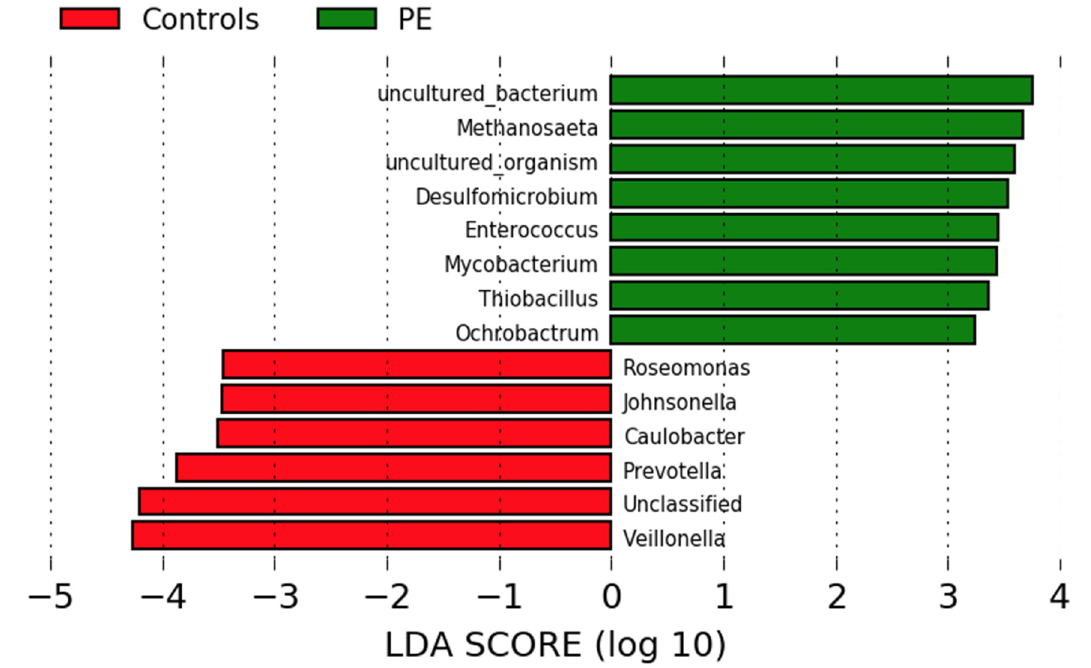
Figure 2. Comparison of the gut microbiota composition in women who developed preeclampsia and normotensive women. LEfSe analysis at the genus level of the oral microbiota of women who developed preeclampsia (green) and who remained normotensive (red).